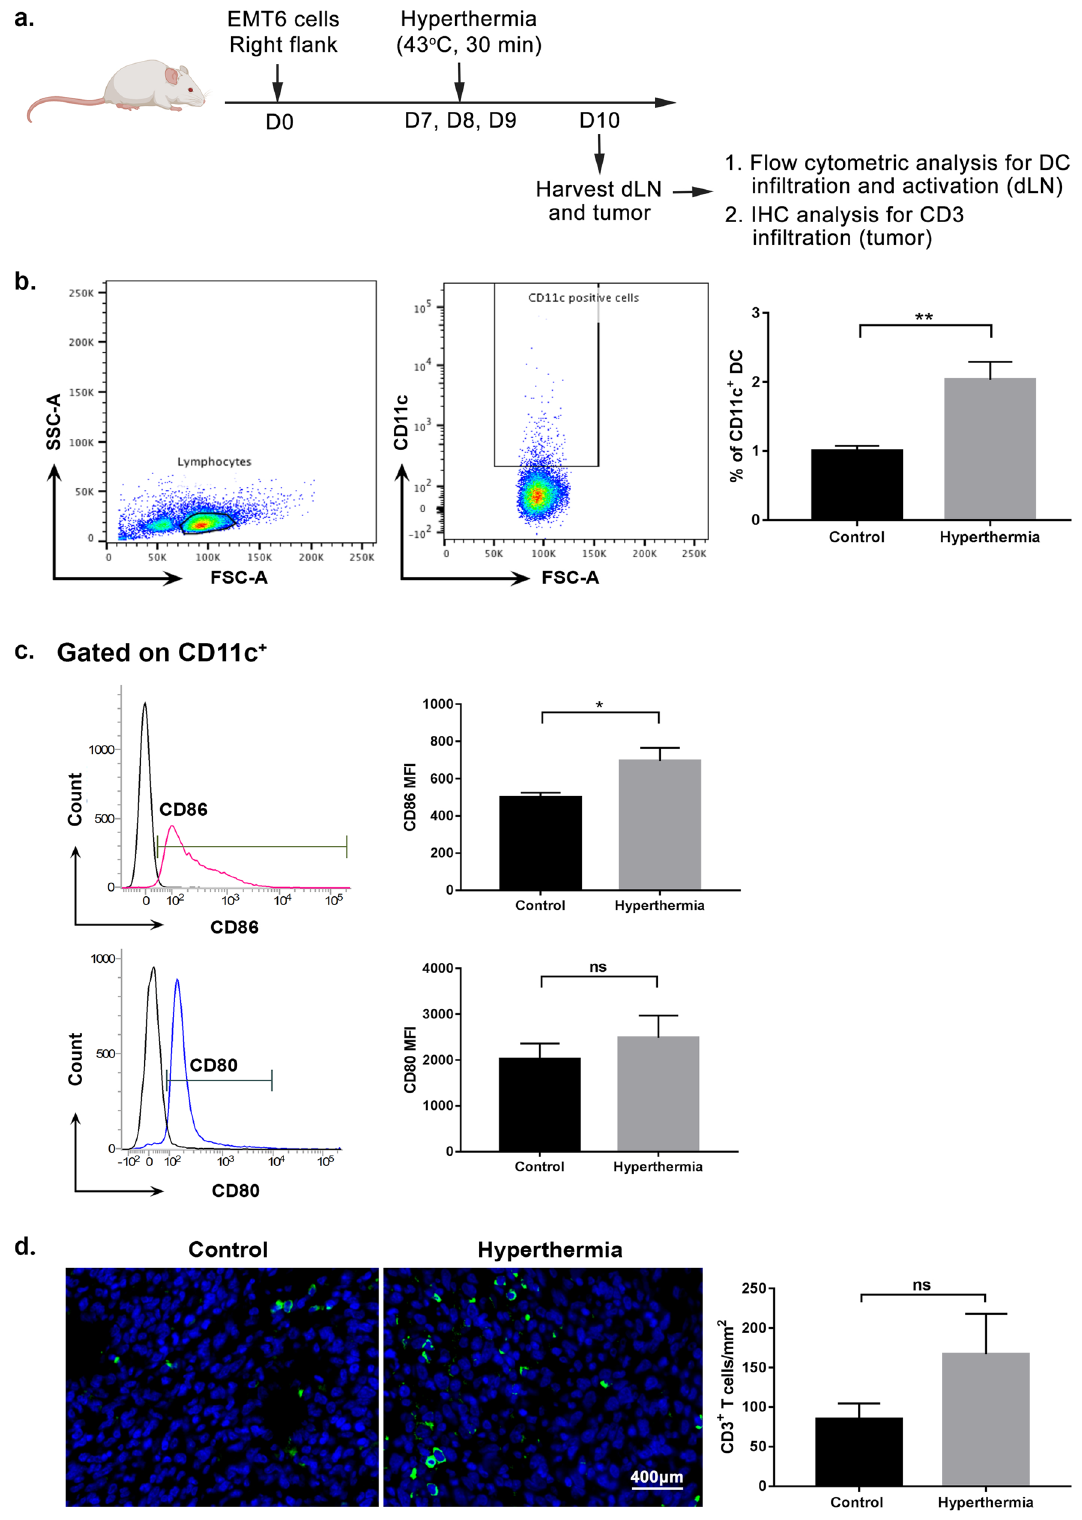
Figure 4. Local hyperthermia by NIR increases DC activation in lymph node and tumor-infiltrated T cells. Mice were sacrificed 3 days after the first treatment. Lymph nodes were analyzed by flow cytometric analysis while tumor was stained for immunohistochemical analysis . ( a ) Schematic timecourse to measure the activation of DC in dLN and the infiltration of CD3 T cells in tumor. ( b ) Dot plot showing the gating strategy of CD11c. Cells were gated based on forward and side scatter profile to exclude the doublet cells. Lymphocytes were then gated and further analyzed for the percentage of CD11c as shown in graph. DCs activation increases following hyperthermia treatment, compared to untreated group. ( c ). Graph showing Mean Fluorescence Intensity (MFI) of CD80 and CD86 expression (± mean) on CD11c + cells. ( d ) CD3 T cell numbers are shown as the median of CD3 cells per mm 2 . Each point represents an individual mouse. n = 5/6 per group. ns- P > 0.05, * P < 0.05, ** P < 0.005 (Student’s t